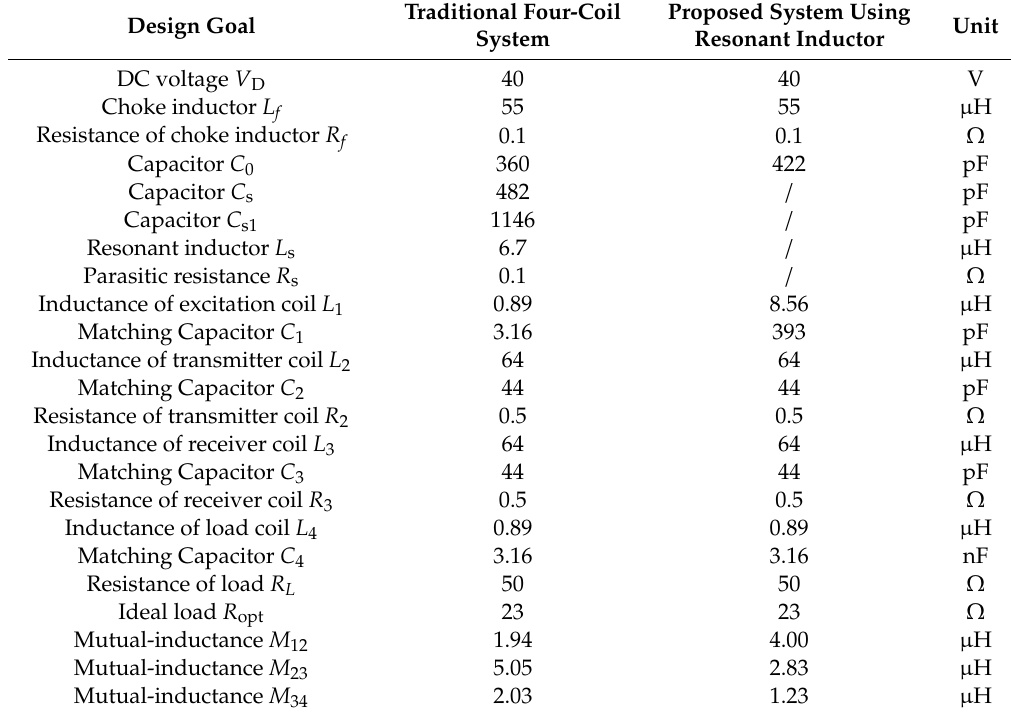
Table 4. Circuit parameters of the two types of WPT systems.